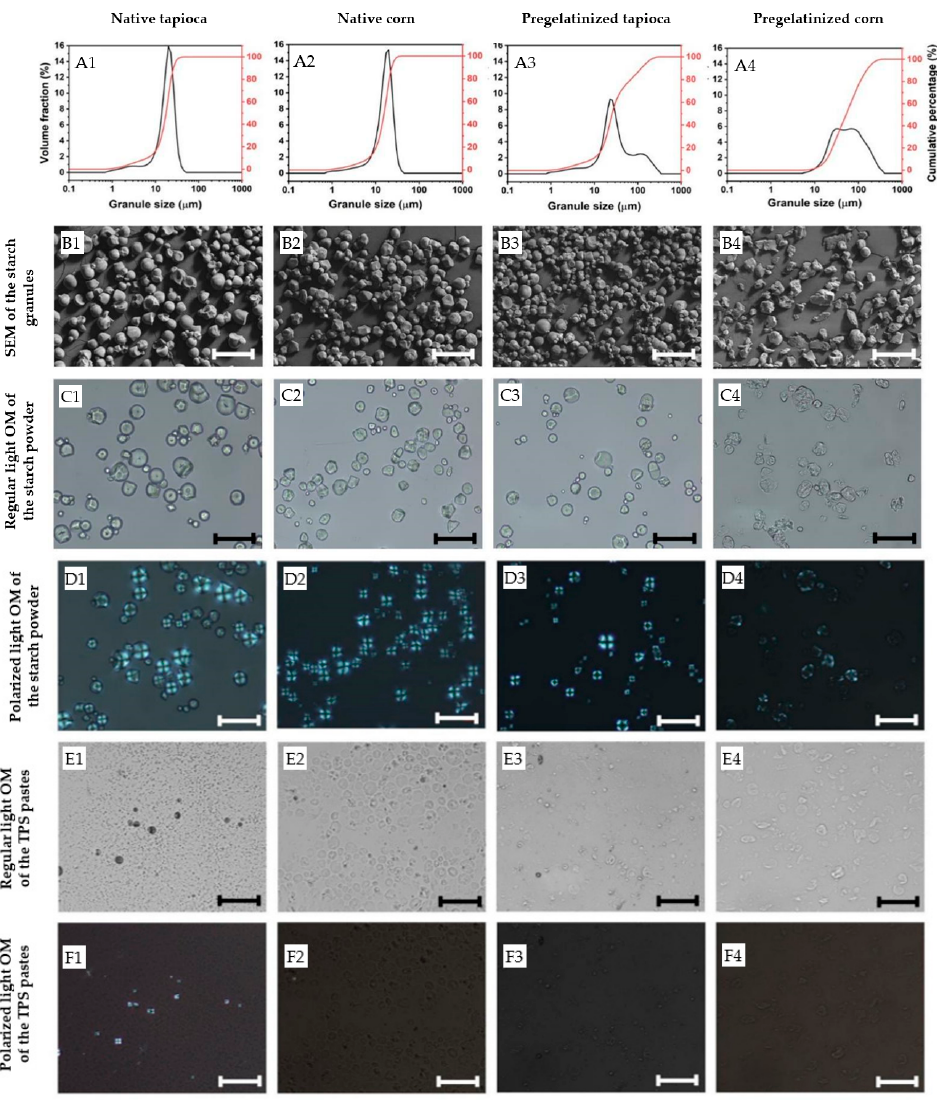
Figure 3. ( A1 – A4 ) Granule size distribution and morphology of the starch granules under ( B1 – B4 ) SEM, and ( C1 – C4 ) regular and ( D1 – D4 ) polarized light optical microscope (OM) images of the starch granules and ( E1 – E4 ) regular and ( F1 – F4 ) polarized light optical microscope (OM) images of the starch granules the pastes after TPS processing. Scale bar = 50 μ m. Figure 3 also highlights the significant impact of starch pre-treatment from the sup- plier on granule size distribution. Due to granule agglomeration, pregelatinized starches exhibited slightly larger granule sizes (see Table 3). The distribution curves of the four